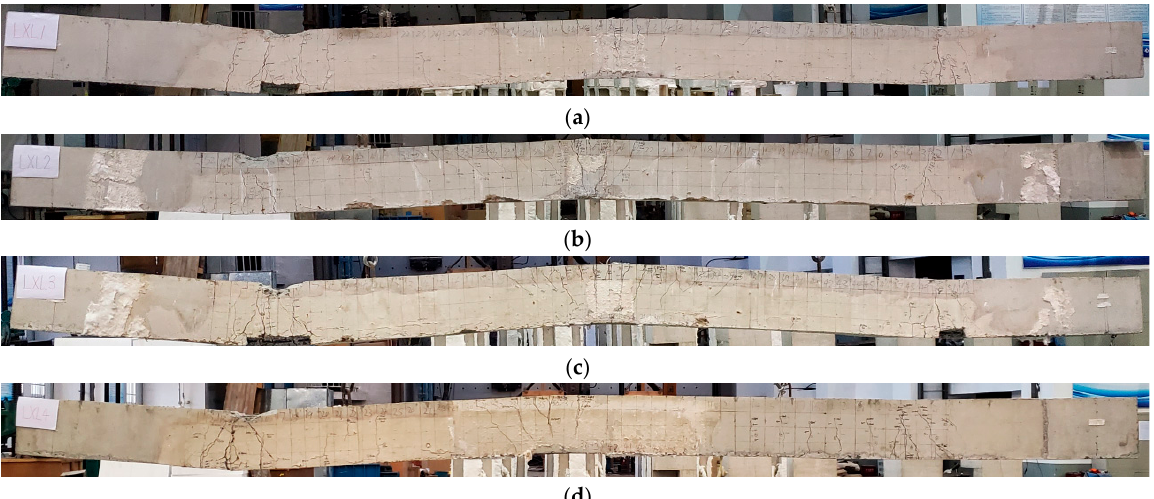
Figure 7. Failure modes of SSB under fire: ( a ) SSB-1; ( b ) SSB-2; ( c ) SSB-3.